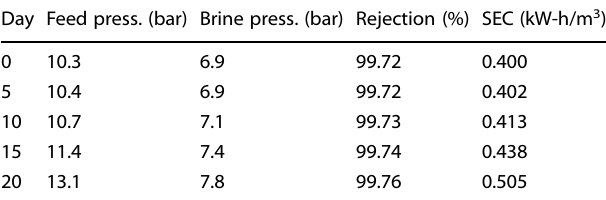
Fig. 7 Model illustration of biofouling effects on RO membrane system key performance indicators. Impacts of biofouling on feed pressure, brine pressure and permeate TDS concentration. Table 4. Impact of biofouling on system average key performance